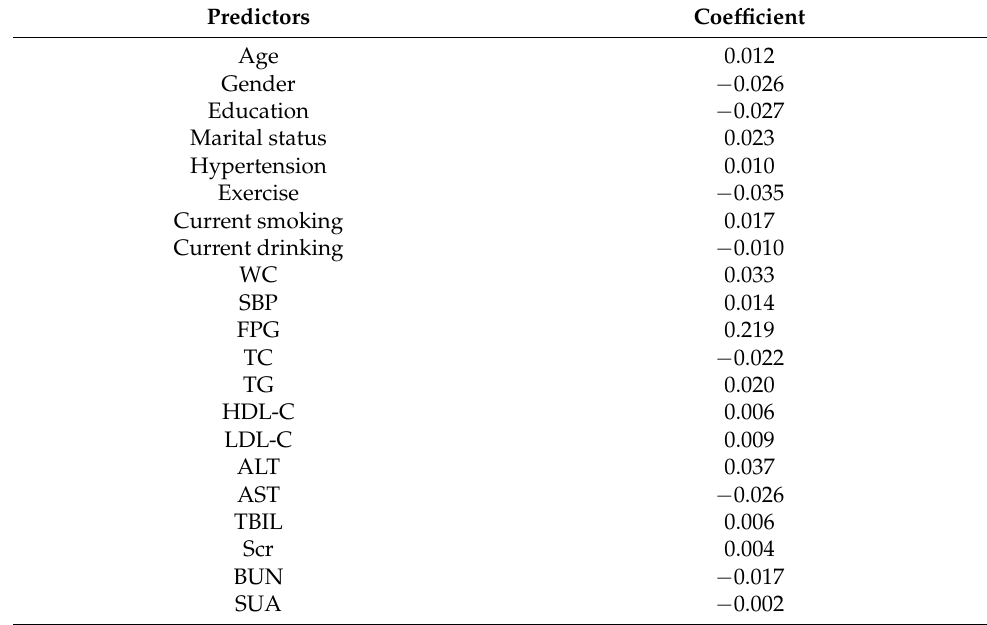
Table 2. Least Absolute Shrinkage and Selection Operator (LASSO) regression